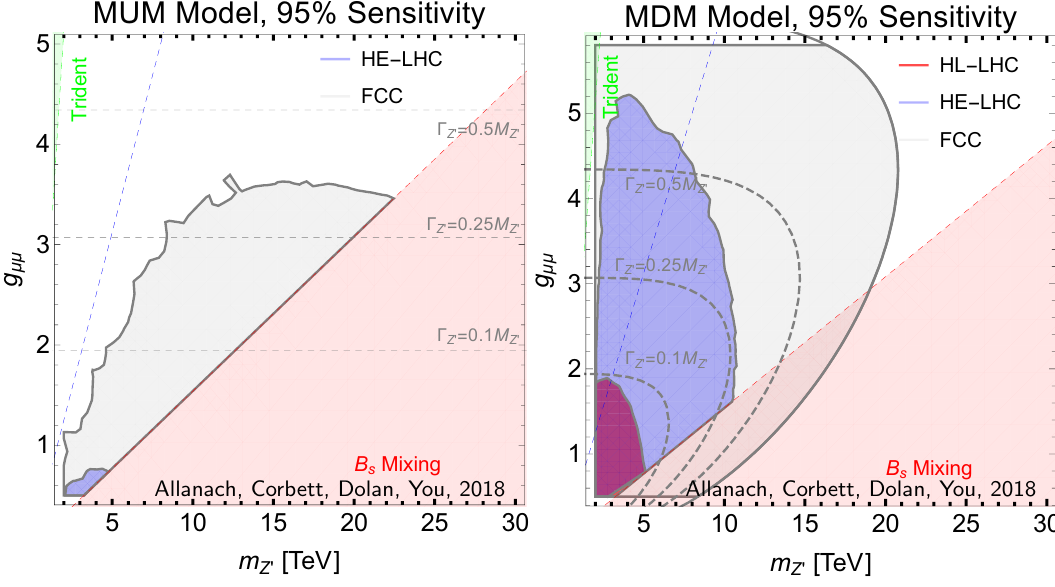
Figure 11 . Summary of MUM model and MDM model 95% sensitivities for future hadron colliders: the 100 TeV FCC with 10/ab integrated luminosity, 27 TeV HE-LHC with 15/ab and the 14 TeV LHC with 3/ab integrated luminosity. Each point in the plane (cid:12)ts the neutral current B -anomalies, since eq. (2.2) with x = 1 : 00 has been enforced meaning that g bs / M 2 =g (cid:22)(cid:22) . The solid lines Z 0 show the regions of 95% CL and 99% CL sensitivity being below each contour. The region ruled out by the B s mixing constraint [57] is shown in red while the region derived from ref. [61] would be below the blue-dashed line. The grey dashed lines show the values of the relative decay width (cid:0) Z 0 =M Z 0 . The FCC reach is shown in grey and extends throughout the whole perturbative region where (cid:0) Z 0 =M Z 0 < 1 in the MDM